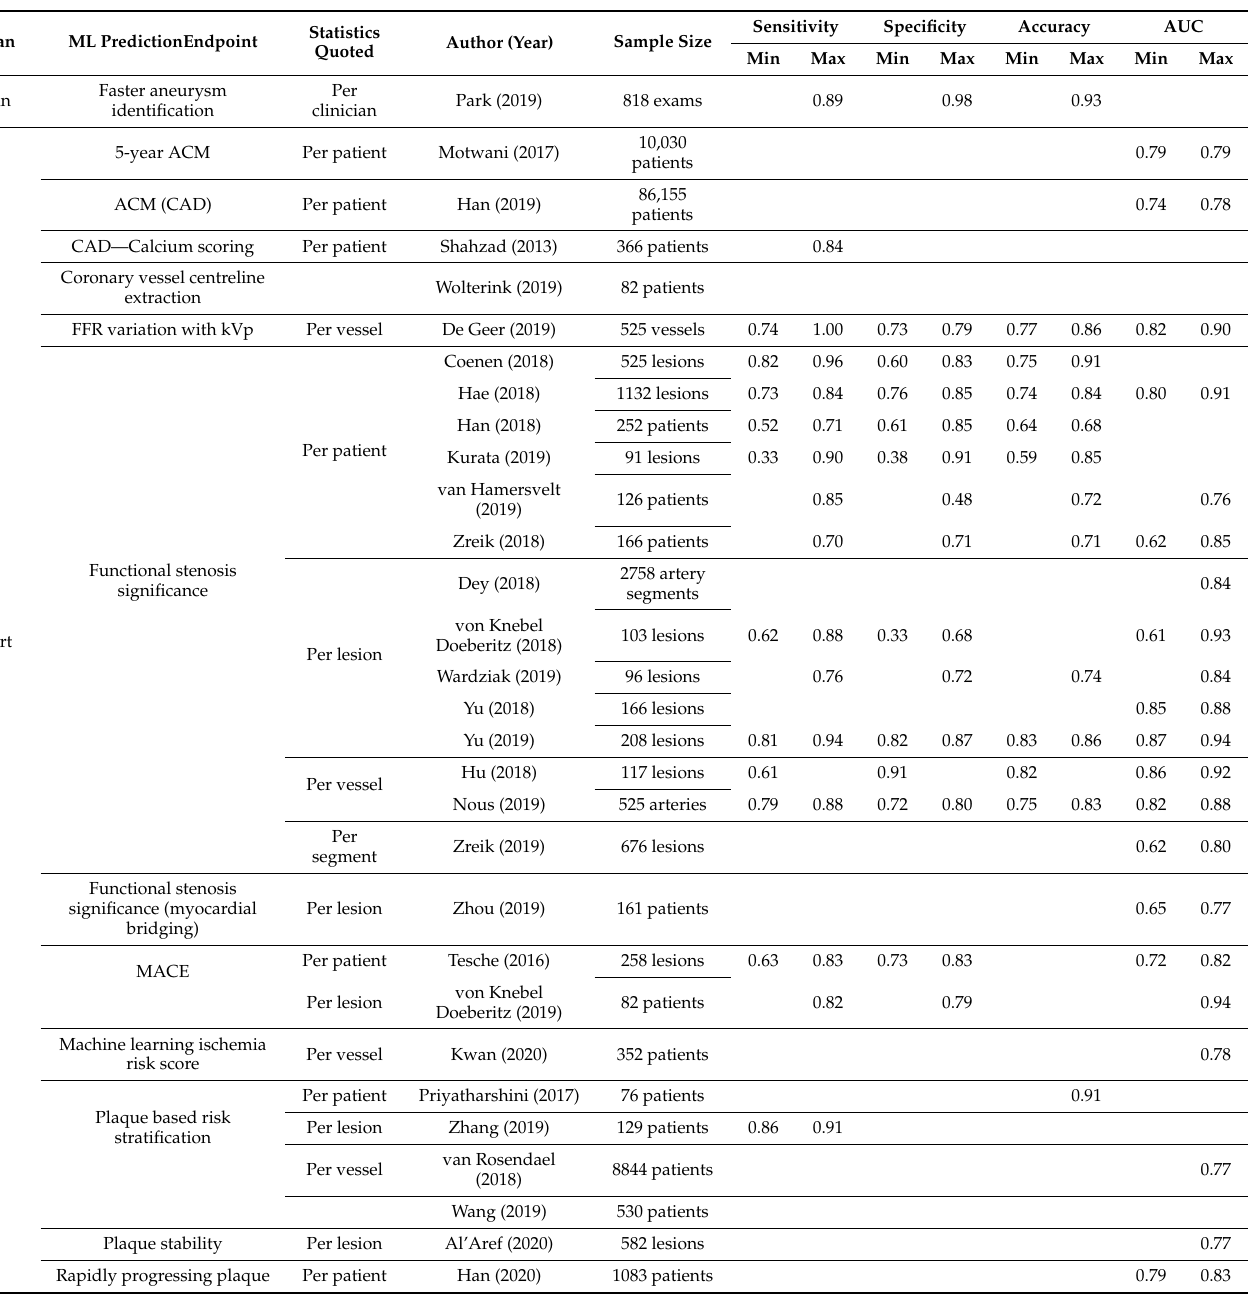
Table 2. Model performance statistics for machine learning (ML) quantitation using